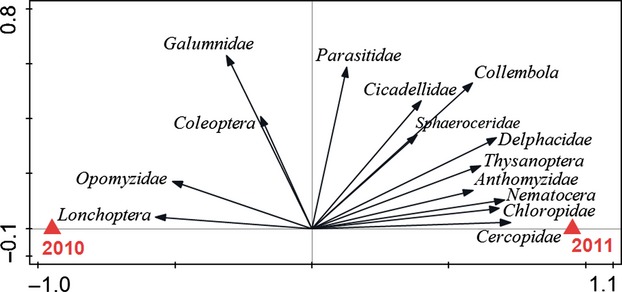
Biplots based on partial redundancy analyses of invertebrate community abundance in an old field with respect to the effect of year. The 14 best fitting of 27 invertebrate groups are displayed.